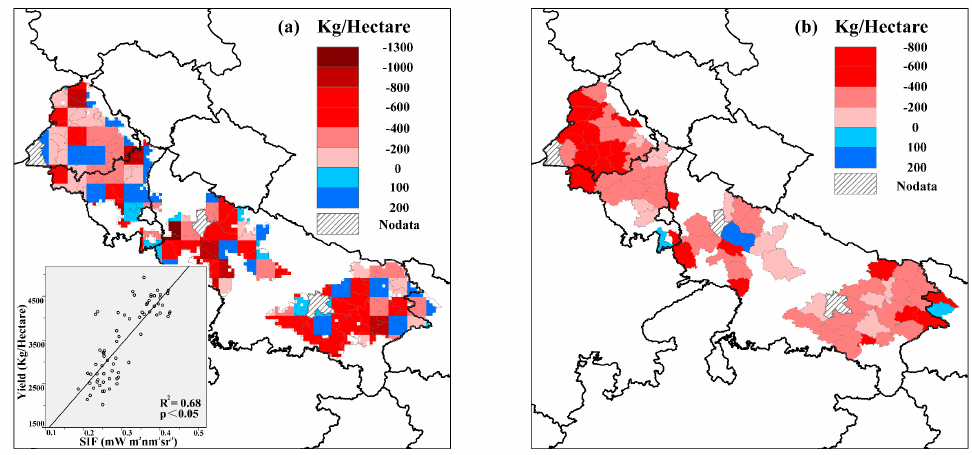
Figure 7. Spatial distributions of 2010 winter wheat yield loss based on ( a ) SIF and ( b ) district-level statistical reports. The scatter plots in the bottom-left corner show the linear regression model that describes the relationship between the yield and SIF, each dot represents the mean SIF in March–April and statistical yield for each district in 2010.